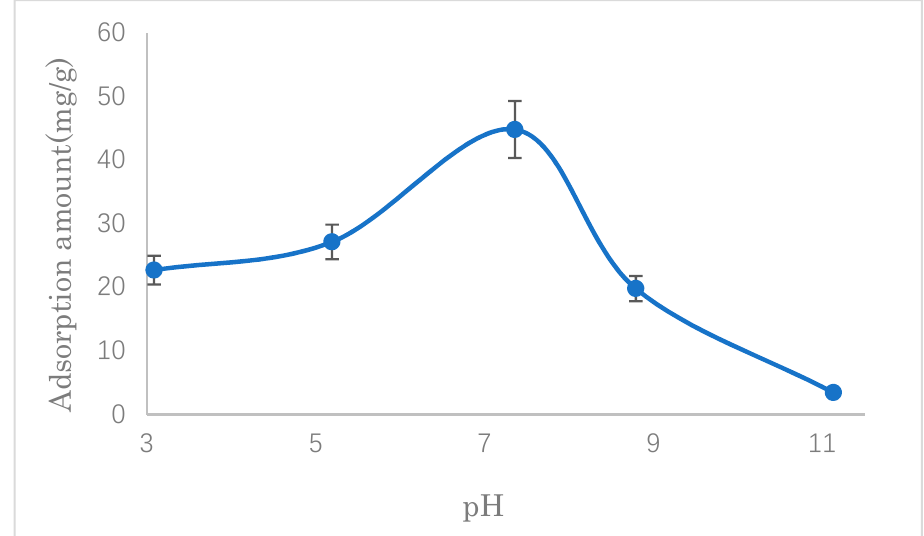
Figure 8. Effect of pH on SDS adsorption.